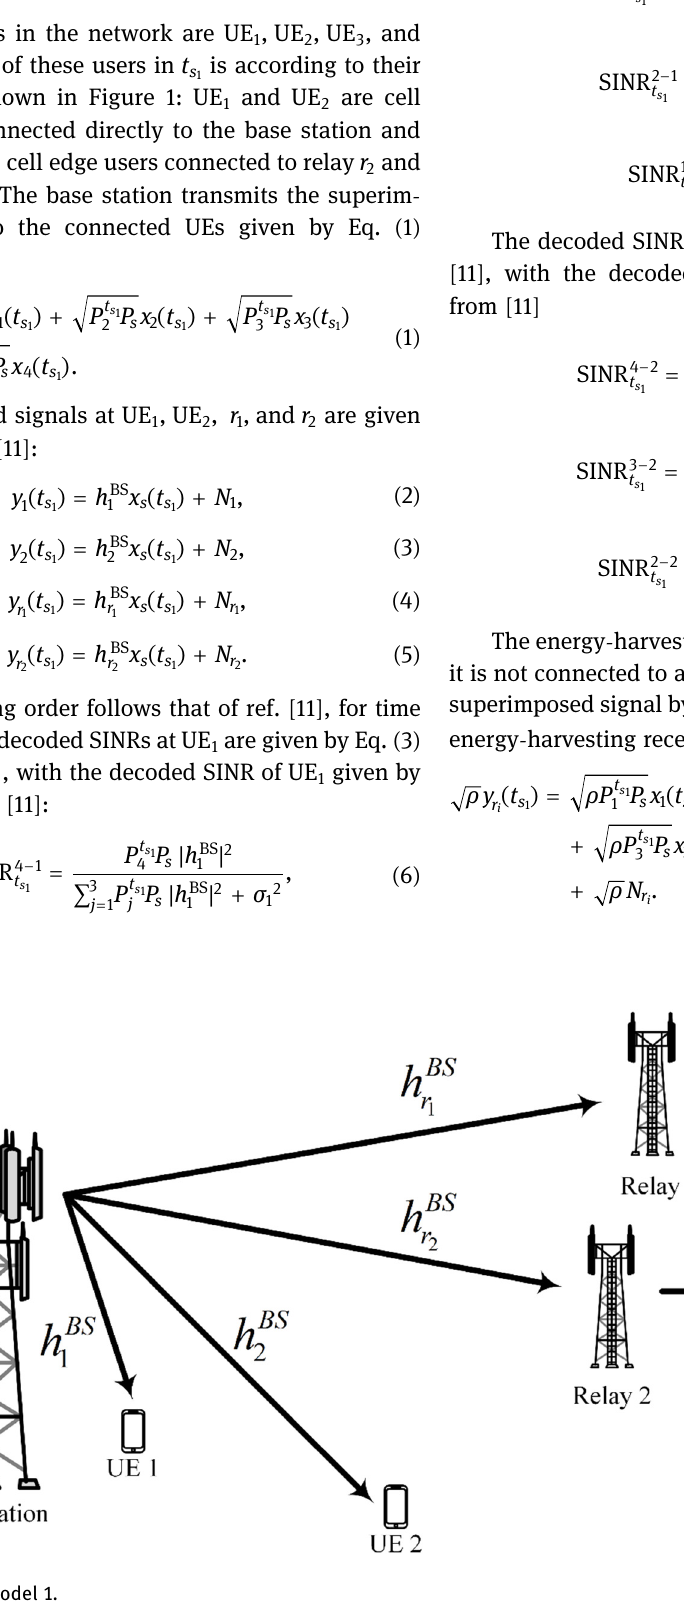
Figure 1: System model